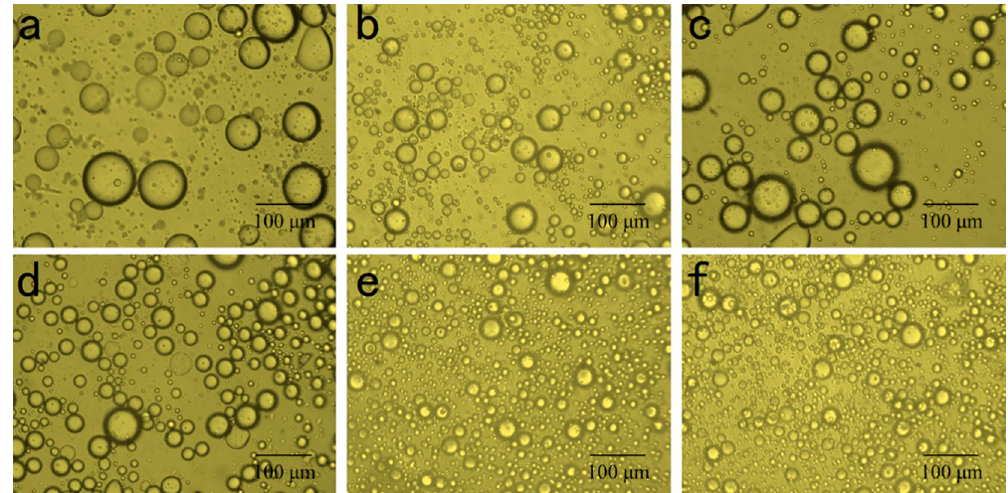
Figure 7. Optical photomicrographs of emulsions of 11S globulin exposed to mild heating ( c ) 50 °C, ( d ) 60 °C, mild heating combined with ultrasound ( e ) Ultrasound-50 °C; ( f ) Ultrasound-60 °C, ( b ) ultrasound alone and ( a ) untreated 11S globulin as control.